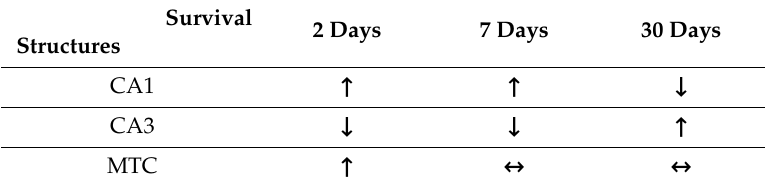
Table 4. Changes in the expression of the Alzheimer’s disease-associated presenilin 2 gene in di ff erent brain structures at di ff erent times after experimental brain ischemia. Survival 2 Days 7 Days 30 Days Structures CA1 ↑ ↑ ↓ CA3 ↓ ↓ ↑ MTC ↑